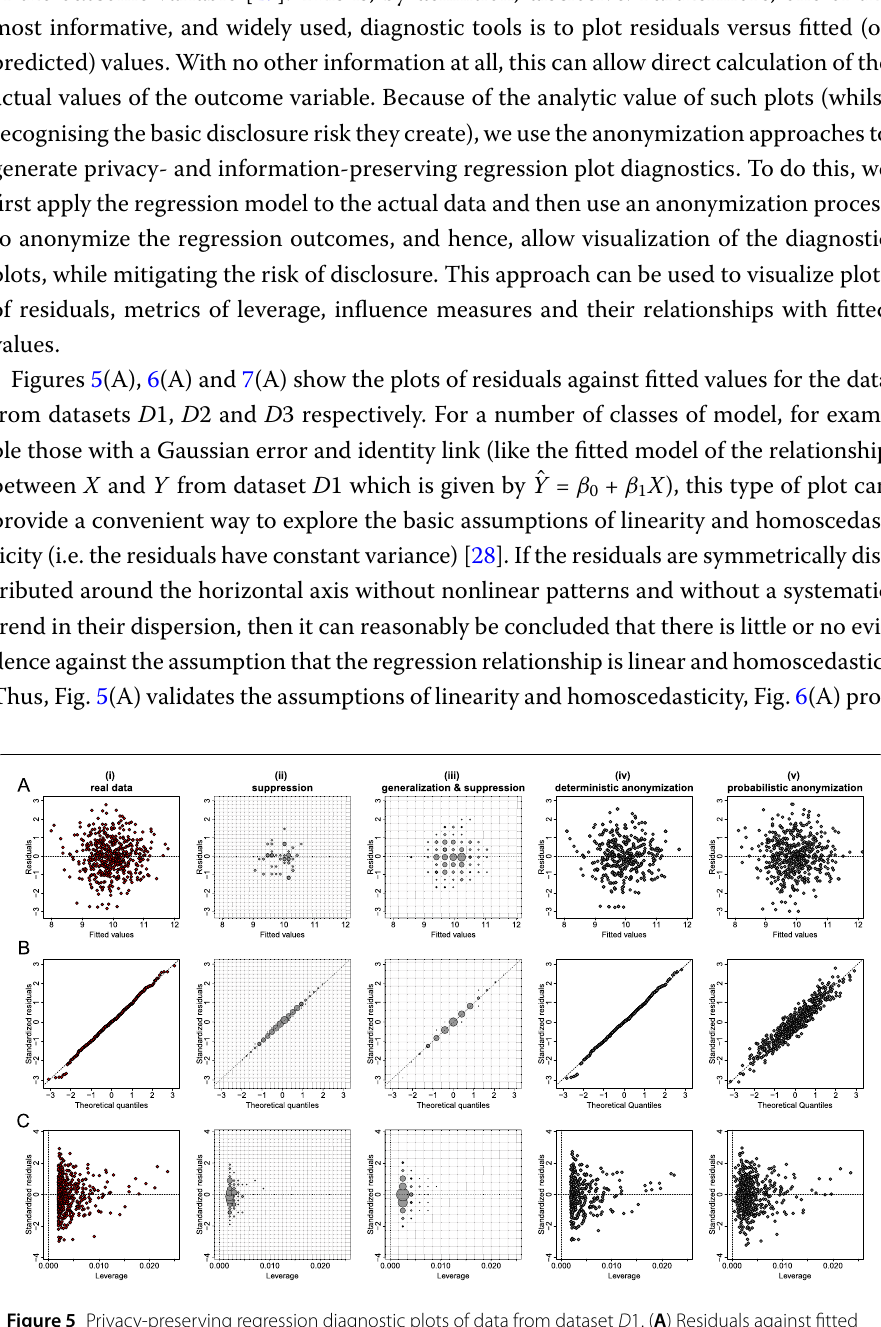
Figure 5 Privacy-preserving regression diagnostic plots of data from dataset D 1. ( A ) Residuals against fitted values; ( B ) Normal QQ plots; ( C ) Residuals against leverage. From left to right we demonstrate the plots: (i) for real regression outcomes; (ii) the regression outcomes aggregated in a 30 by 30 density grid matrix and suppressing any grids with density less than three counts; (iii) the regression outcomes aggregated in a 15 by 15 density grid matrix and suppressing any grids with density less than three counts; (iv) the scaled centroids of each 3-nearest neighbours of the regression outcomes obtained by deterministic anonymization; (v) the noisy regression outcomes obtained by probabilistic anonymization. Note that for plots B and C we use the standardized residuals that are the residuals divided by their standard